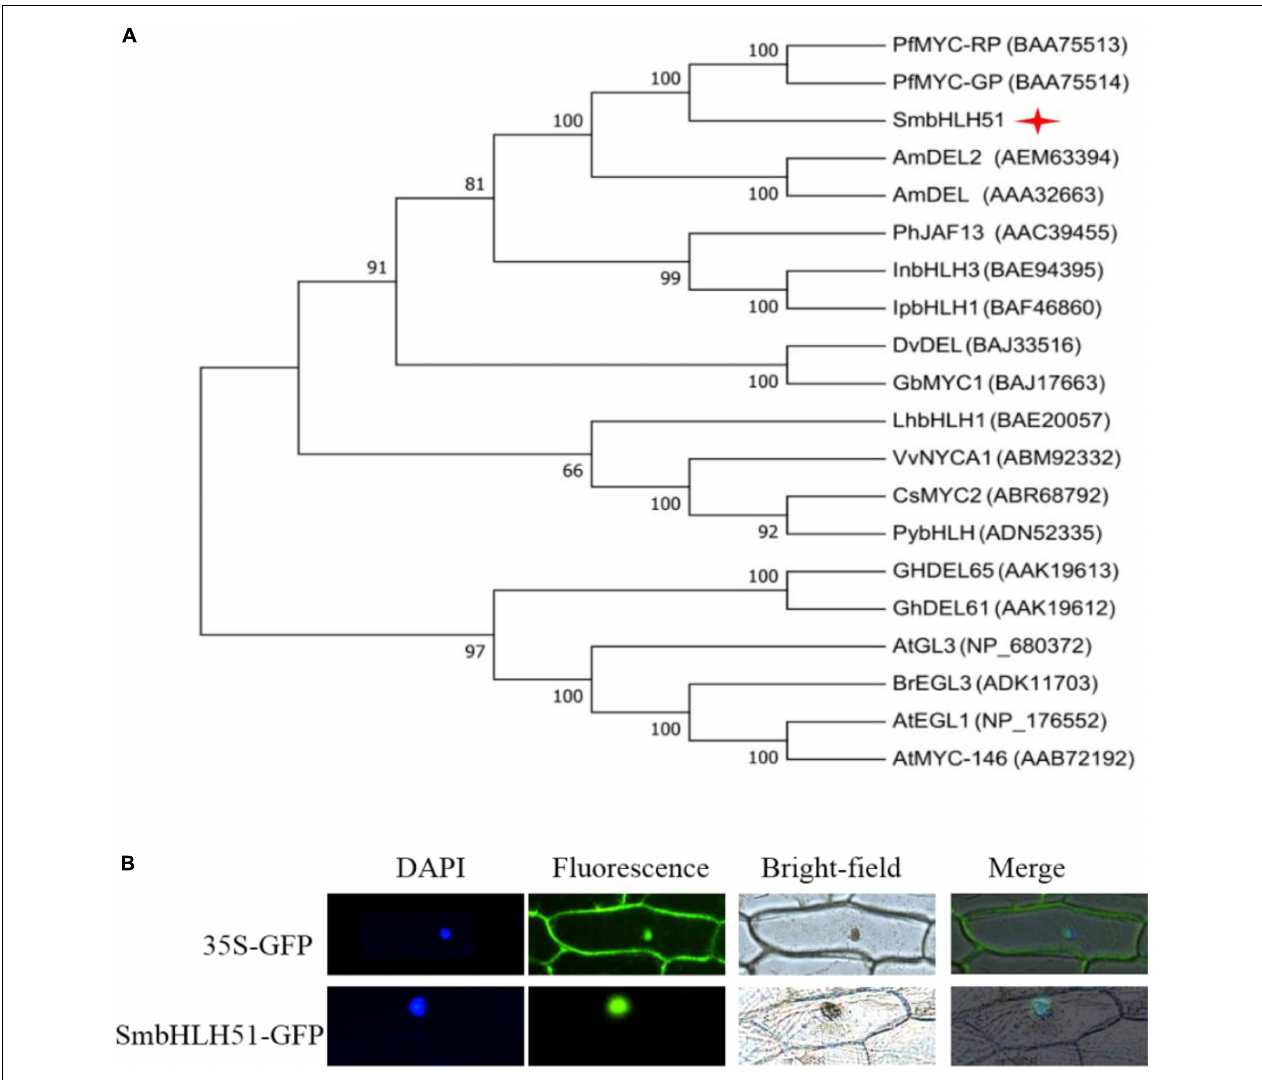
FIGURE 2 | Sequence analysis of SmbHLH51 and subcellular localization. (A) Phylogenetic tree of SmbHLH51 and bHLH protein sequences from other species. (B) Subcellular localization of SmbHLH51 in onion epidermal